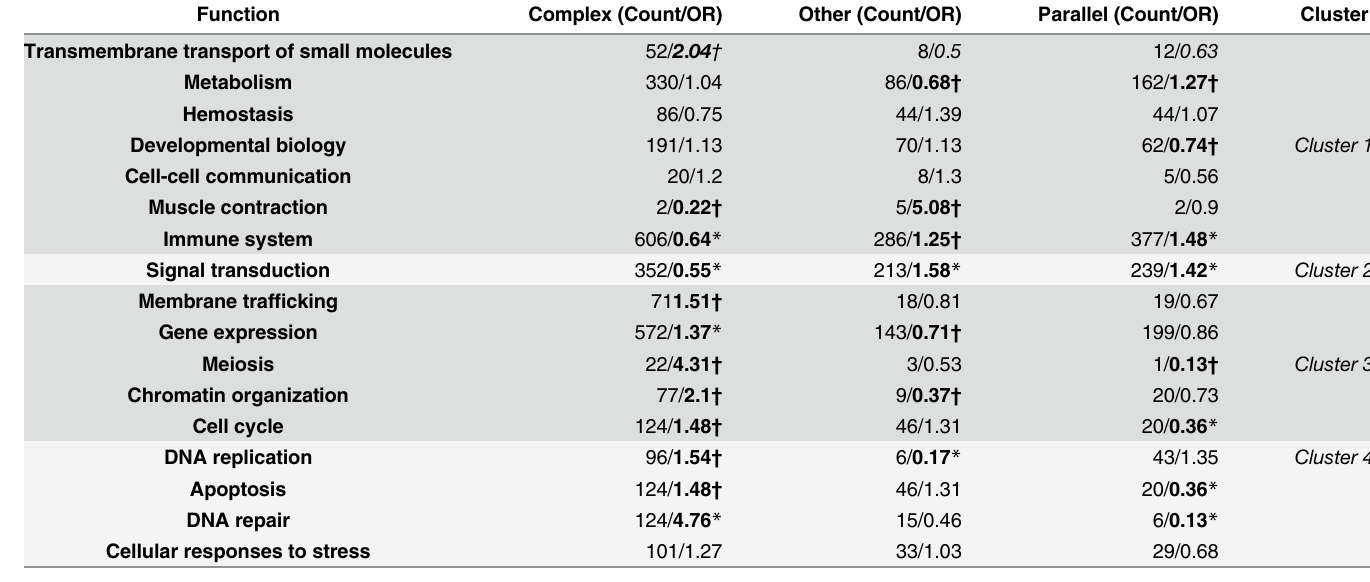
Table 4. Within-function enrichment of putative SL pairs based on gene product interactions. Complex describes all gene pairs that are within the same pathway. Other represents all pairs that have another described PPI. Parallel refers to all pairs with no known PPI between them. Interactions are deter- mined using Reactome